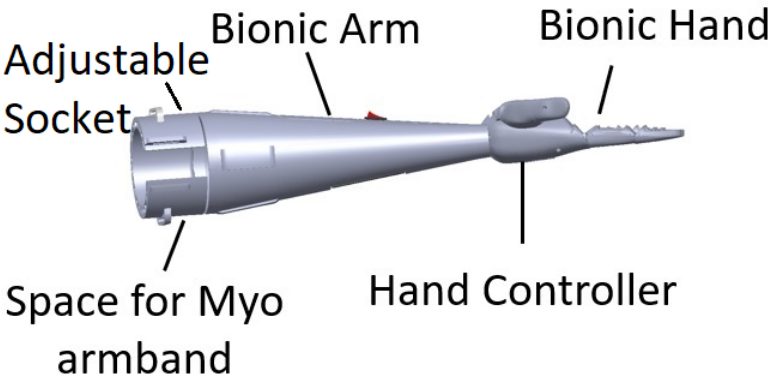
Figure 4. Bionic arm 3D model on computer-aided design (CAD) software.